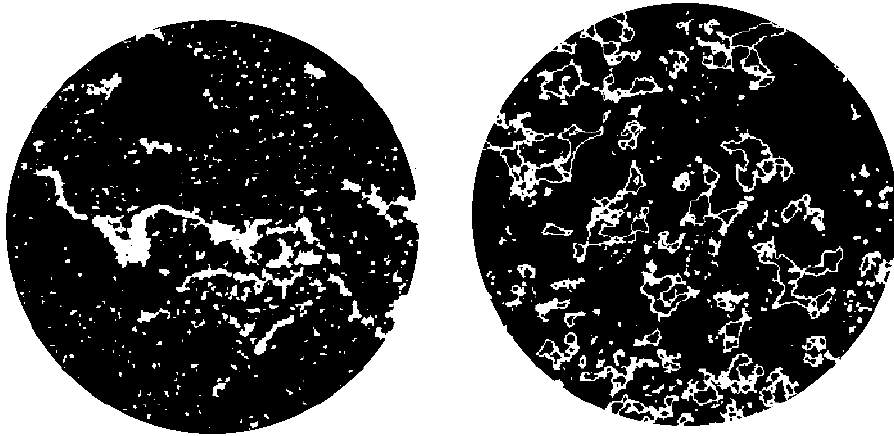
Figure 15. X-ray CT images of 0% (left) and 1% (right) CB content clay bricks.